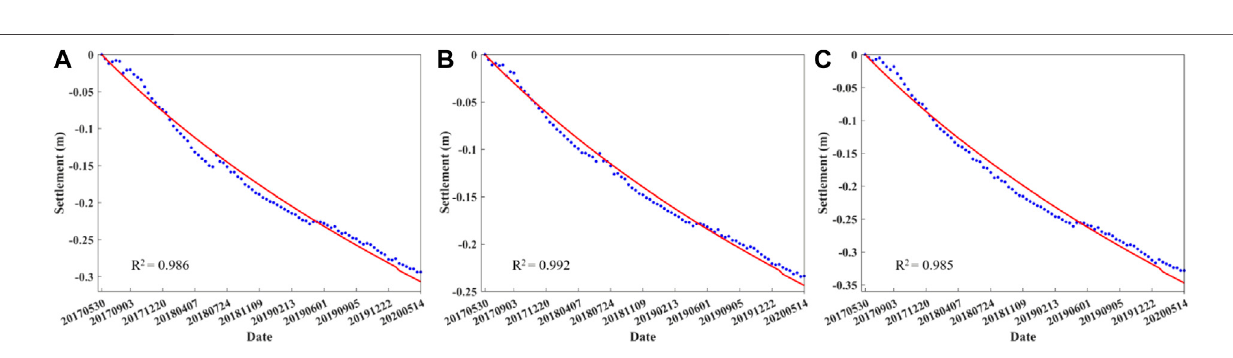
Frontiers in Environmental Science |